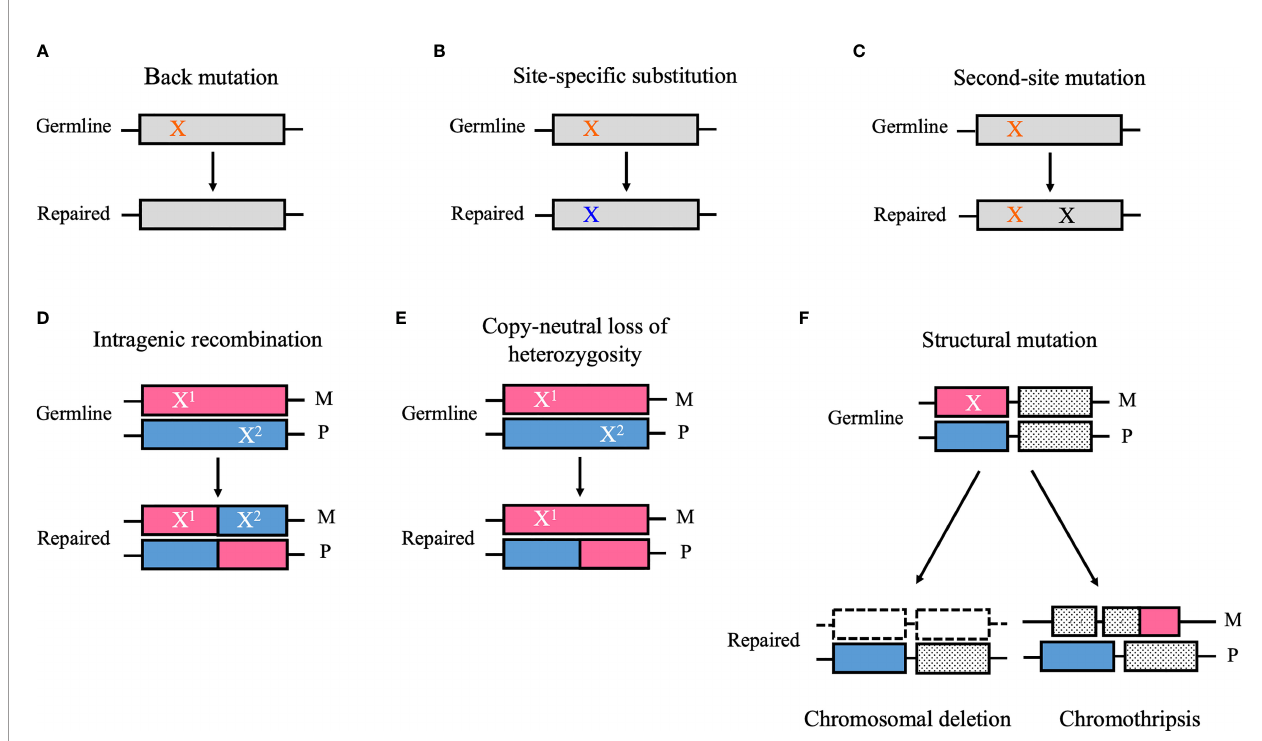
FIGURE 1 | Schematic diagrams of the reversion mechanism. (A) A germ line point mutation (orange “ X ” ) is changed to the wild-type sequence (i.e., back mutation). (B) A germ line point mutation substitutes for a nucleotide other than the wild-type sequence (blue “ X ” ), which restores the original amino acid sequence or results in the alternation to a less deleterious amino acid than in the original germline mutation (i.e., site-speci fi c substitution). (C) A mutation that occurs at a different site from the germline mutation but within the coding or noncoding regions of the same gene (black “ X ” ) can cause a compensatory change that abrogates the deleterious effect of the germline mutation (i.e., second-site mutation). (D) Intragenic recombination can lead to reversion through the generation of a wild-type allele, whereas the other allele carries both germline mutations (i.e., X 1 and X 2 ). (E) Copy-neutral loss of heterozygosity can eliminate the chromosomal region encompassing the germline mutation and replace it a copy of the wild-type chromosome from the other parent. (F) A structural mutation such as chromosomal deletion and chromothripsis can abrogate a deleterious gain-of-function mutation ( “ X ” ) by modifying the chromosomal structure. M, maternal allele; P, paternal allele. (A) Back mutation, (B) Site-speci fi c substitution, (C) Second-site mutation, (D) Intragenic recombination, (E) Copy-neutral loss of heterozygosity, (F) Structural